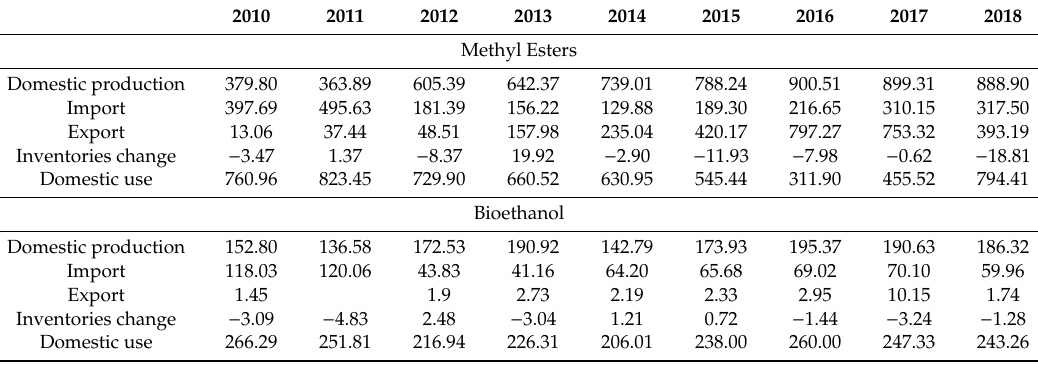
Table 3. Balance of methyl esters and bioethanol in Poland in 2010–2018 (kt).